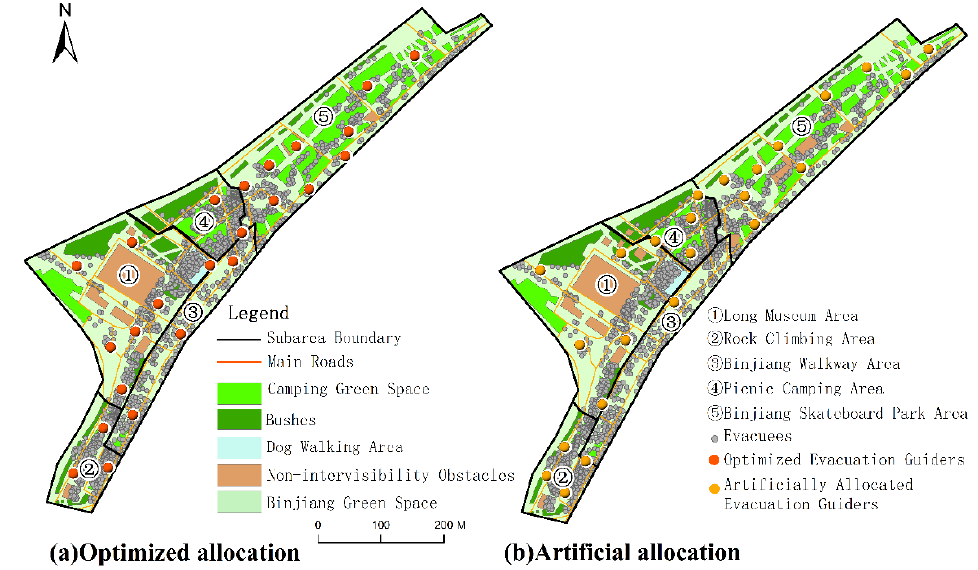
Figure 12. Optimized and artificial allocation results of evacuation guiders at 14:30 on 5 May 2021.